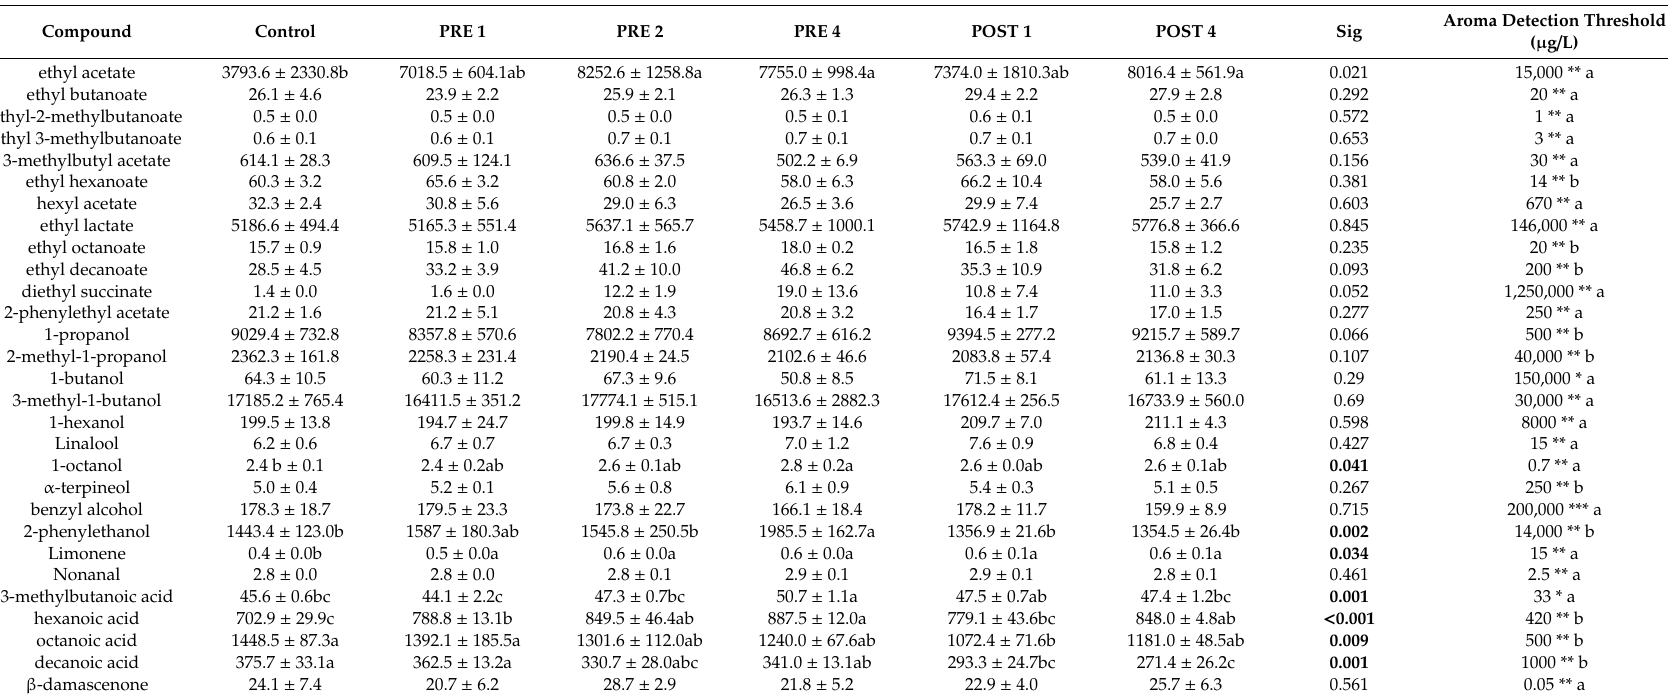
Table 2. Concentration of volatile compounds ( µ g / L) in control and red wines containing GL added pre- or post-fermentation in 28 L